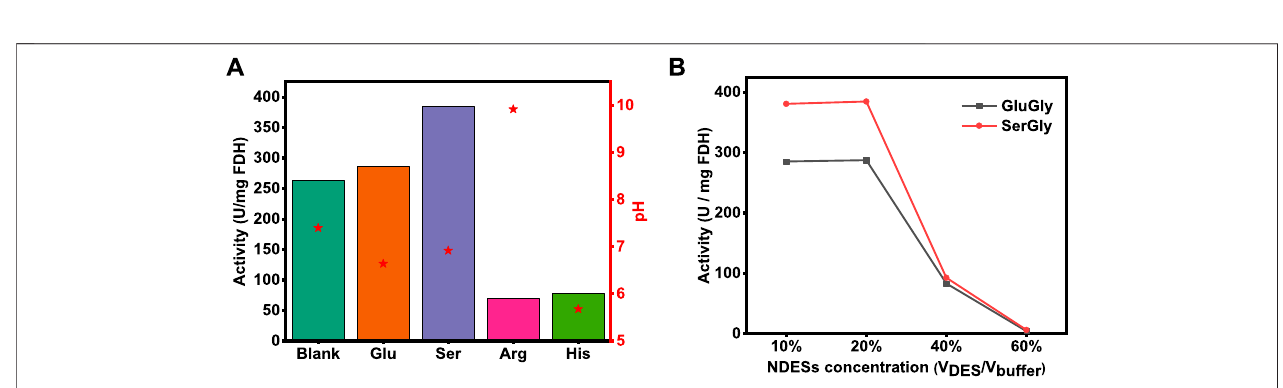
FIGURE 3 | (A) FDH activity in four NADESs-based solutions (20% v/v) and Tris-HCl buffer. (B) FDH activity at different concentrations of SerGly and